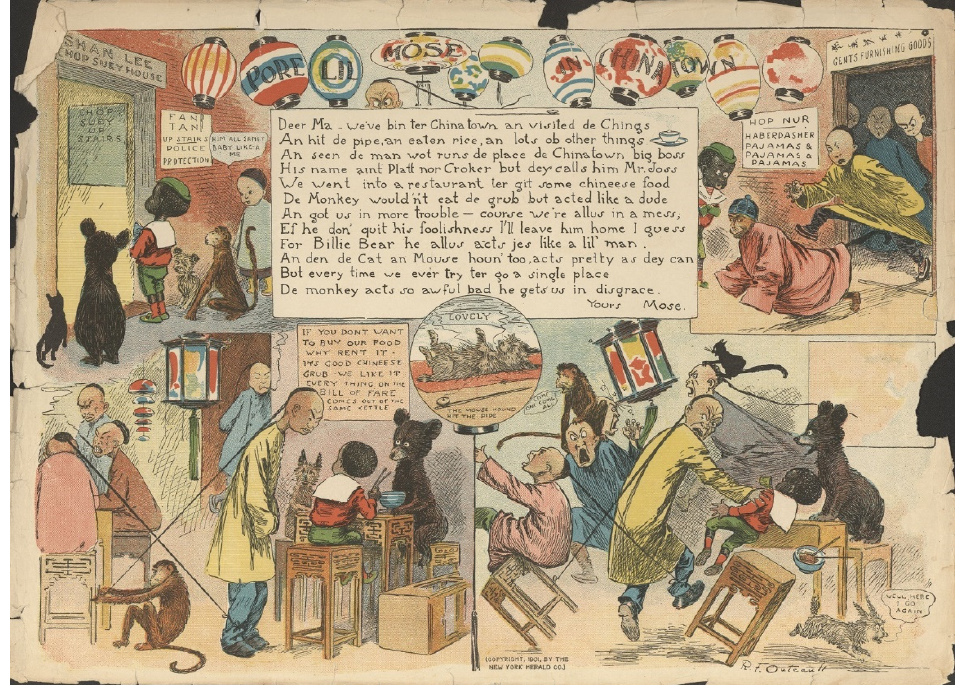
Figure 2. Image of page 38 of Pore lil Mose. Available through Michigan State University Digital Collections: https://d.lib.msu.edu/gnn/1483 (accessed on 4 May 2022).